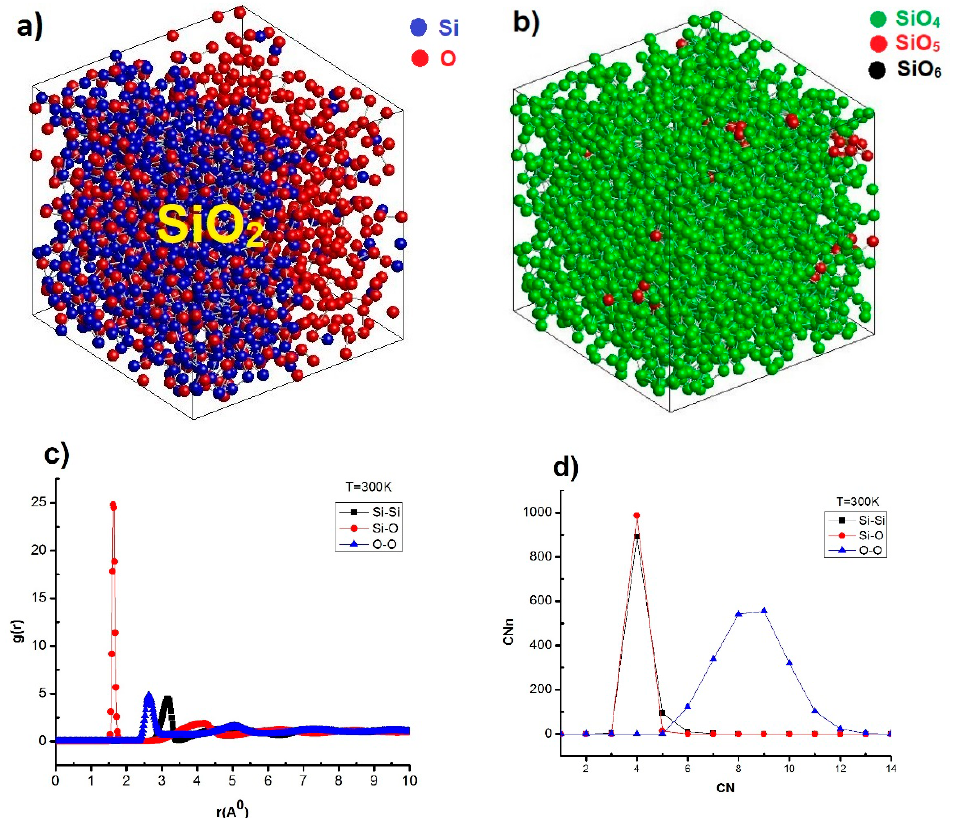
Figure 1. Structural characteristics of bulk SiO2 at T = 300 K, P = 0 GPa: Shape ( a ), the structural unit number ( b ), the RDF ( c ), the CN ( d ).